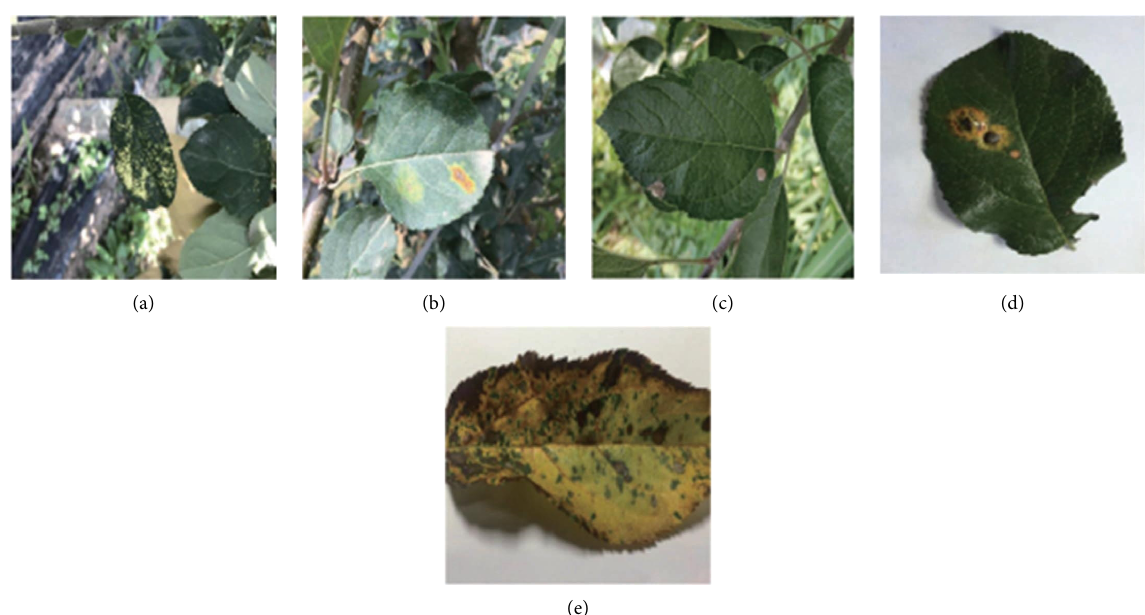
Figure 1: Image of apple leaf disease. (a) Mosaic, (b) rust, (c) grey spot, (d) Alternaria leaf spot, and (e) brown